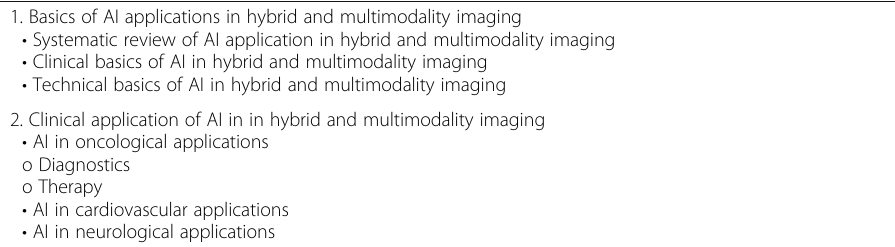
Table 1 List of topics in the artificial intelligence thematic